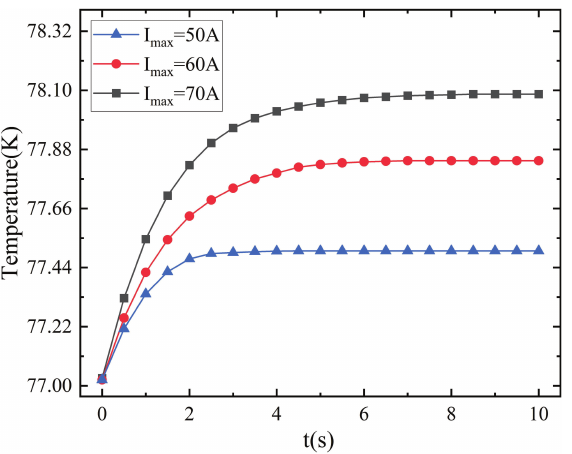
Figure 7. The time evolutions of the temperature of the 8th